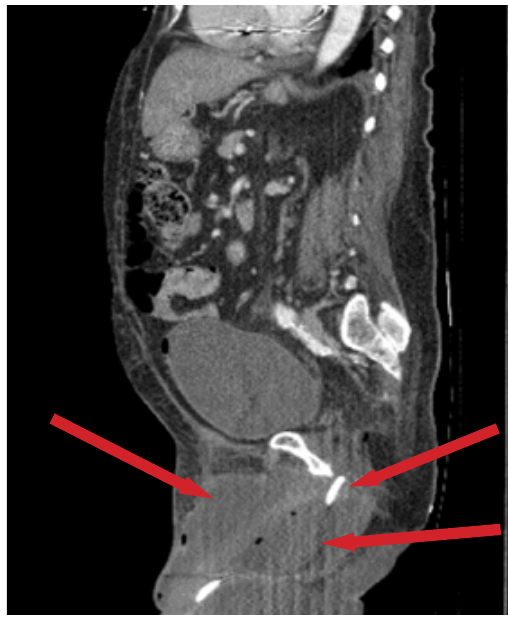
figure 3 - Urethra was noted (arrow) to be displaced do- wnward and posteriorly by massive urine extravasation in the anterior peri-urethral space (arrow-heads). furthermore, note the subcutaneous air delineating the corpora cavernosa in the penile shaft (curved